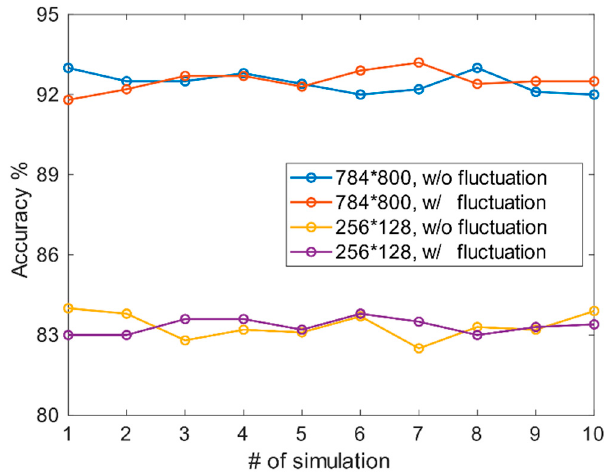
Figure 11. Impact of resistance fluctuation on accuracy.